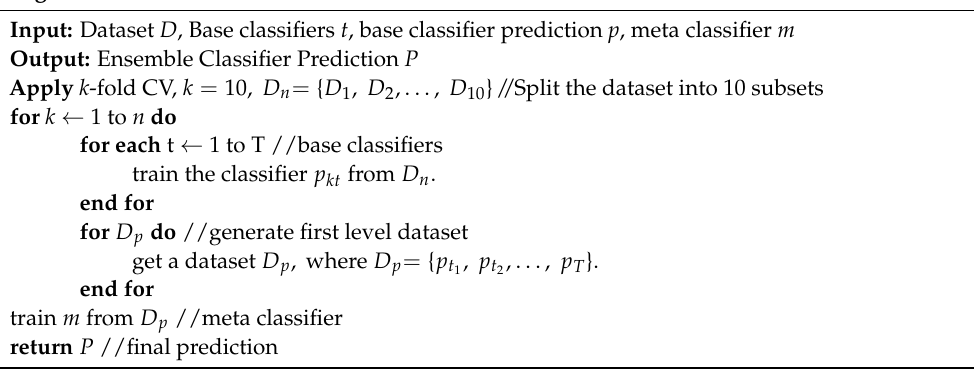
Algorithm 4: Stacked Generalization with k -fold cross-validation